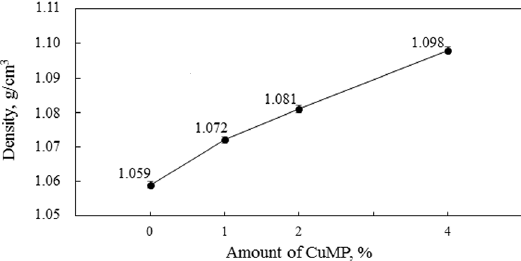
Figure 7. Density values of the compounds as a function of CuMP